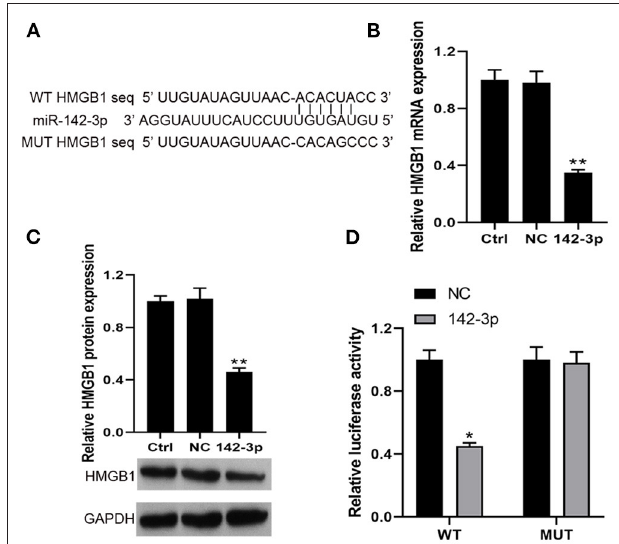
FIGURE 3 | HMGB1 was a direct target of miR-142-3p. (A) The potential miR-142-3p binding sequence of HMGB1 3 ′ UTR and the mutant sequence of HMGB1. (B,C) After transfection with miR-NC or miR-142-3p mimic, HMGB1 mRNA and protein levels were determined by RT-qPCR and Western blot in bone marrow hematopoietic stem cells, respectively. (D) The analysis of the relative luciferase activities of HMGB1. ** P < 0.01 vs. Ctrl group; * P < 0.05 vs. NC group; n =